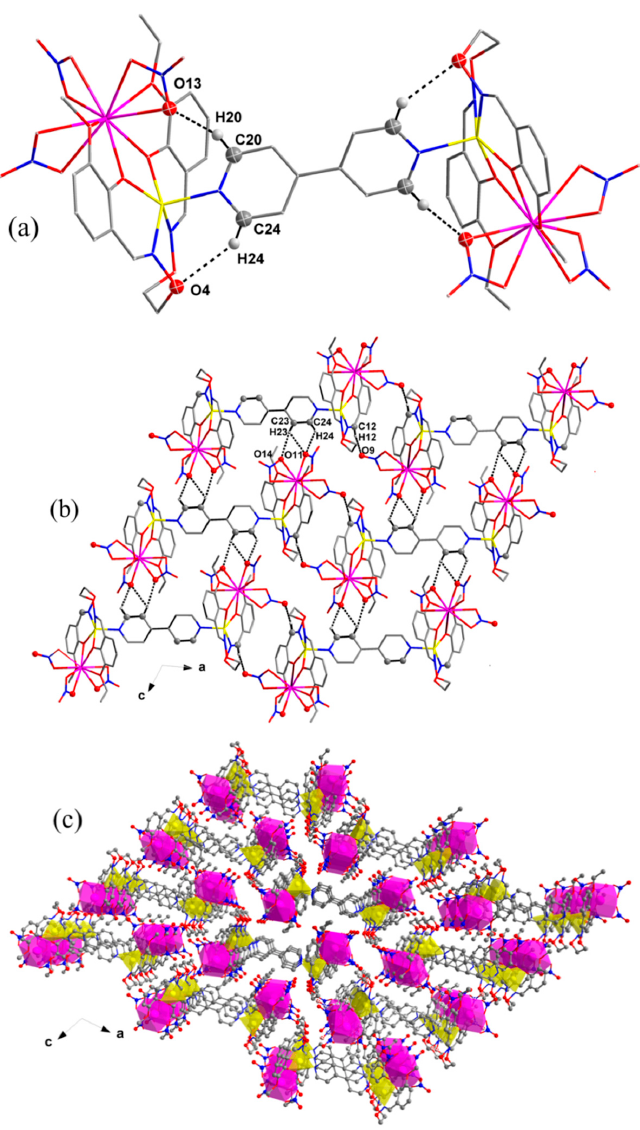
Figure 4. ( a ) Intramolecular hydrogen-bonding interactions of the [Zn II2 –Sm III2 ] complex, ( b ) two-dimensional (2-D) supramolecular structure of the [Zn II2 –Sm III2 ] complex, ( c ) three-dimensional (3-D) center perspective structure of the [Zn II2 –Sm III2 ] complex. Table 3. Hydrogen-bonding interactions (Å, ° ) of the [Zn II2 –Sm III2 ] complex.